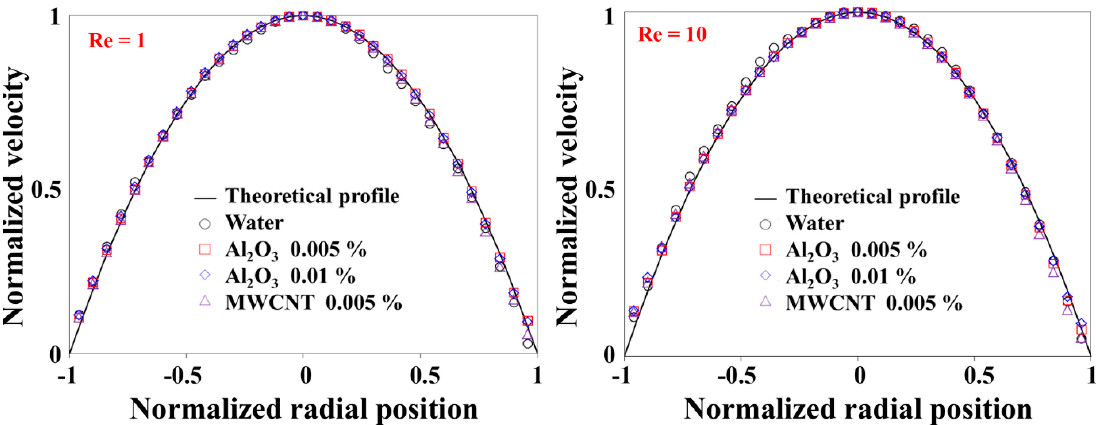
Figure 7. Normalized velocity profiles obtained by micro-particle image velocimetry (PIV) techniques. The measured profiles are compared to the theoretical profile of the Hagen–Poiseuille flow.